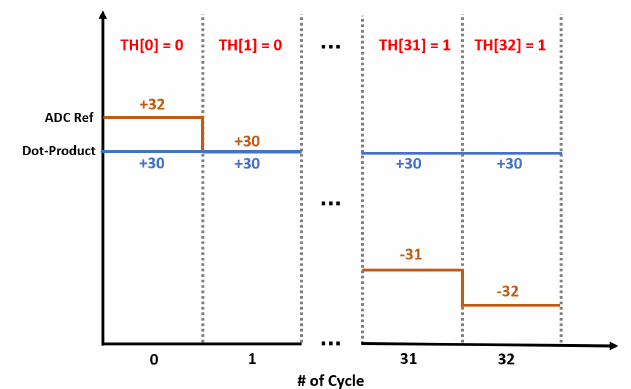
Figure 4. Comparison method for ADC operation (64 × input for 7 bit